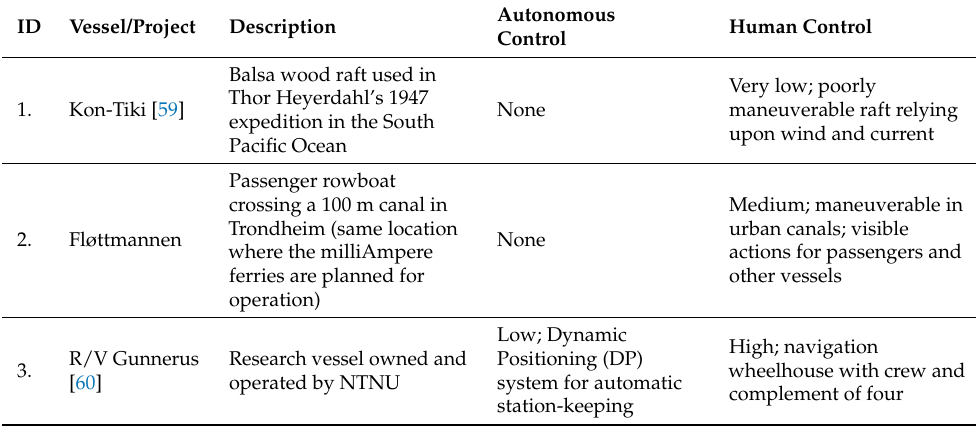
Figure 16. Two-dimensional ‘stages of automation’ plot adapted from [16] showing human-AI system control for various vessels. These are described further in Table 4. Table 4. Stages of automation described for the example shown in Figure 16.